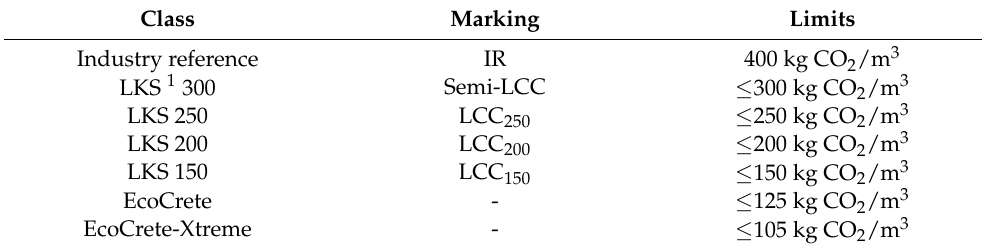
Table 7. Icelandic classification system for LCC